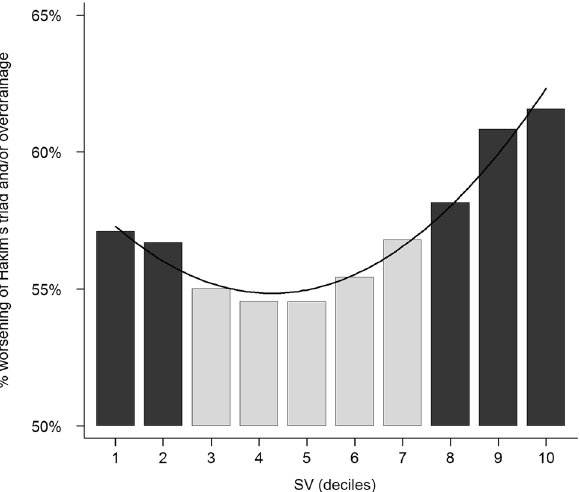
Figure 1. Histogram of the risk of clinical worsening and occurrence of cerebrospinal fluid overdrainage complications as deciles of difference in aqueductal cerebrospinal fluid stroke volume (∆SV). ∆SV indicates the difference between aqueductal cerebrospinal fluid stroke volume values at any clinical check and the previous one. ∆SV deciles corresponding to maximum risk are shown in